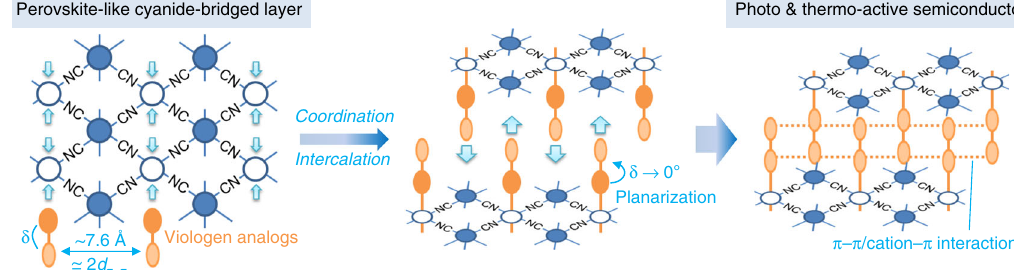
Fig. 1 Design strategy in this work. δ and d π – π denote the interannular angle and common separation for π – π interactions,